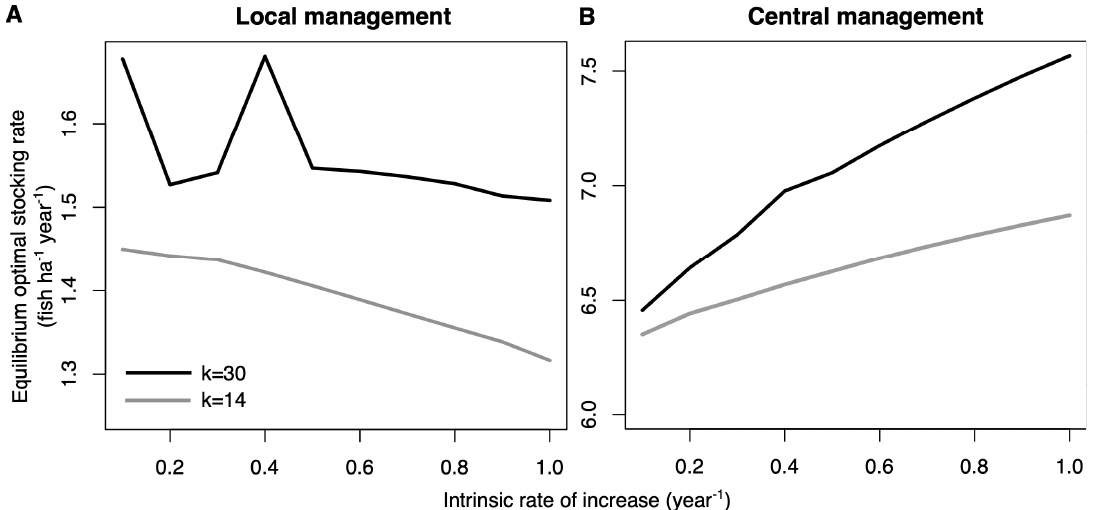
Figure A1.2. Optimal stocking rates for high (black) and low (gray) carrying capacity as a function of the intrinsic rate of increase of the fish population when stocking is conducted by (A) local and (B) centralized